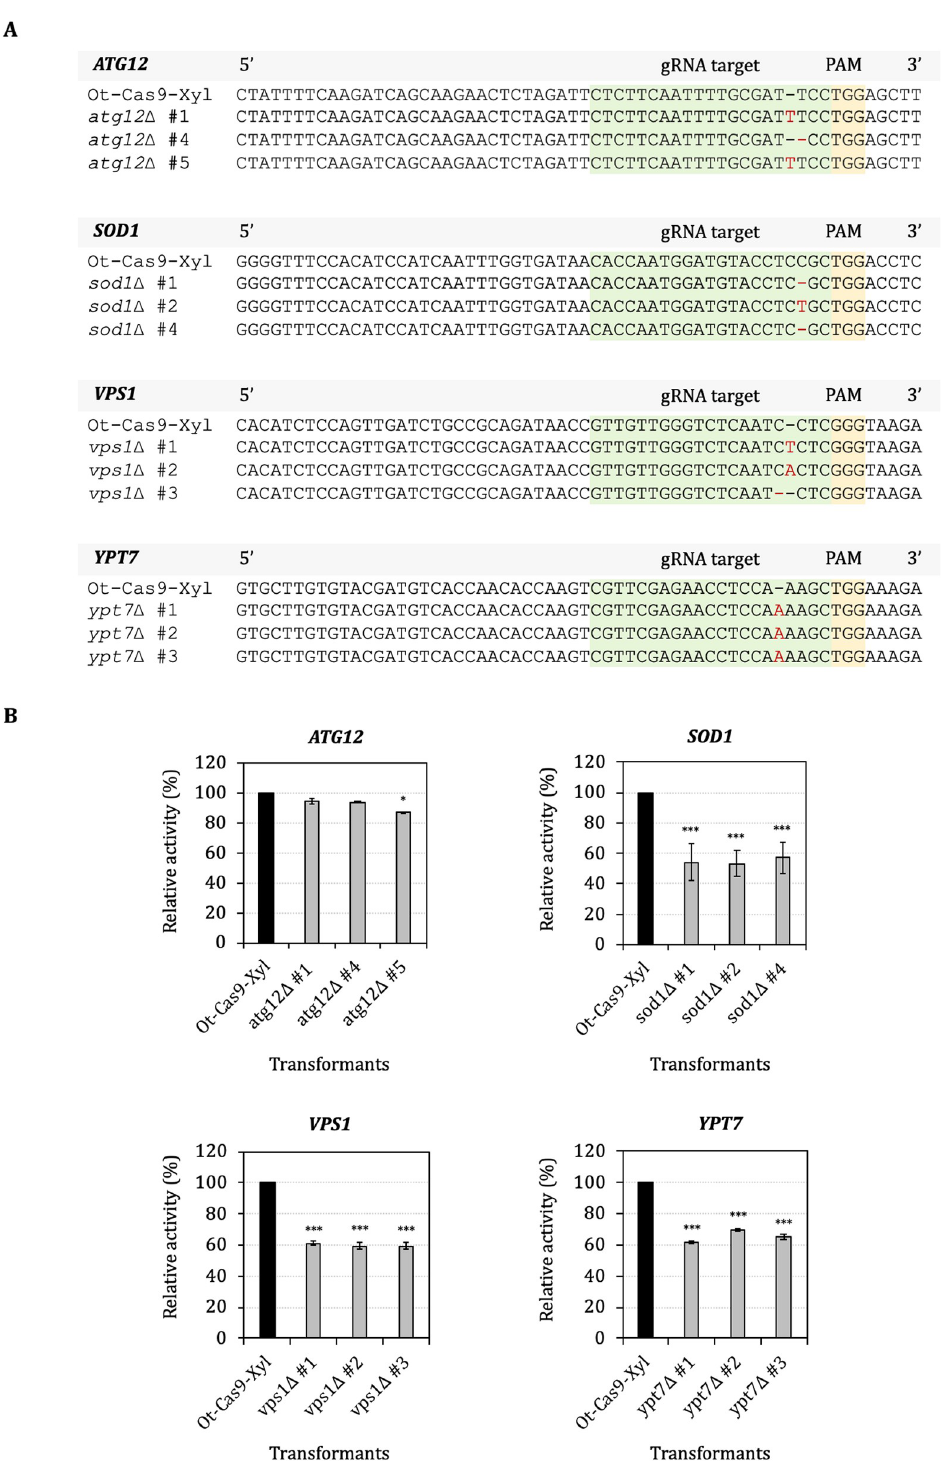
Fig 2. Mutagenesis of protein secretory related genes mediated by CRISPR-Cas9. Multiple sequence alignment of the protein secretory related genes of mutant strains. The modified regions from mutant strains are aligned with the Ot-Cas9-Xyl control. Red dash indicates deletion and red letter indicates insertion mutation (A). Relative activity of xylanase activity (%U/OD) of disrupted mutant yeasts compared with the Ot-Cas9-Xyl control (B). Data are shown as mean ± S.D. from three-independent biological replicate experiments ( n = 3). Asterisks ( � ) indicate significantly altered expression profiles relative to Ot-Cas9-Xyl ( � p < 0.05 and ��� p < 0.001).